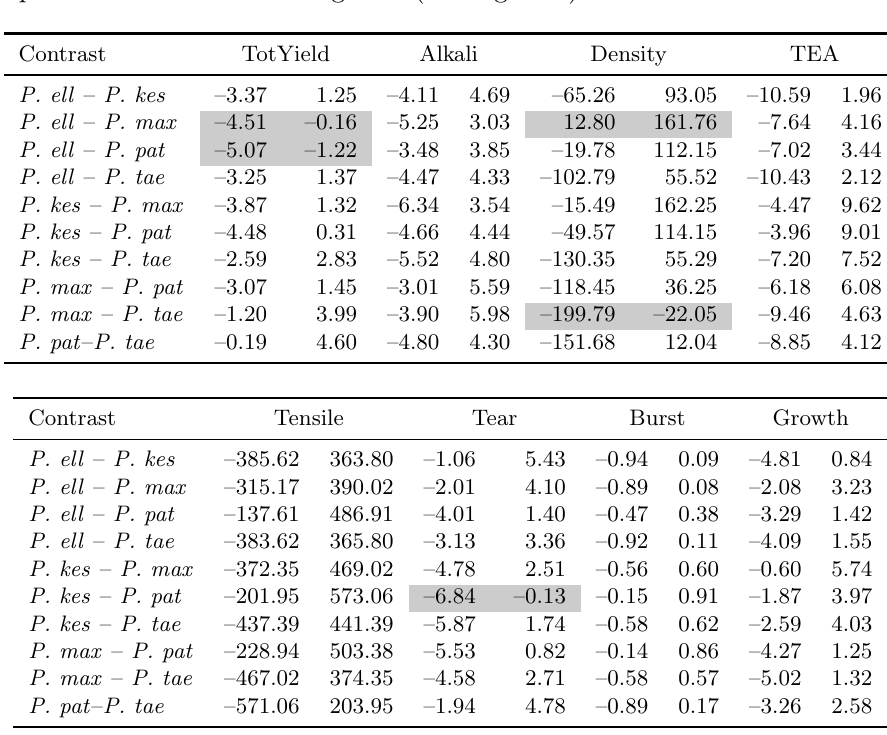
Table 3: Simultaneous Bonferroni 90% confidence intervals for all pairwise contrasts among five pine species. Intervals excluding zero are